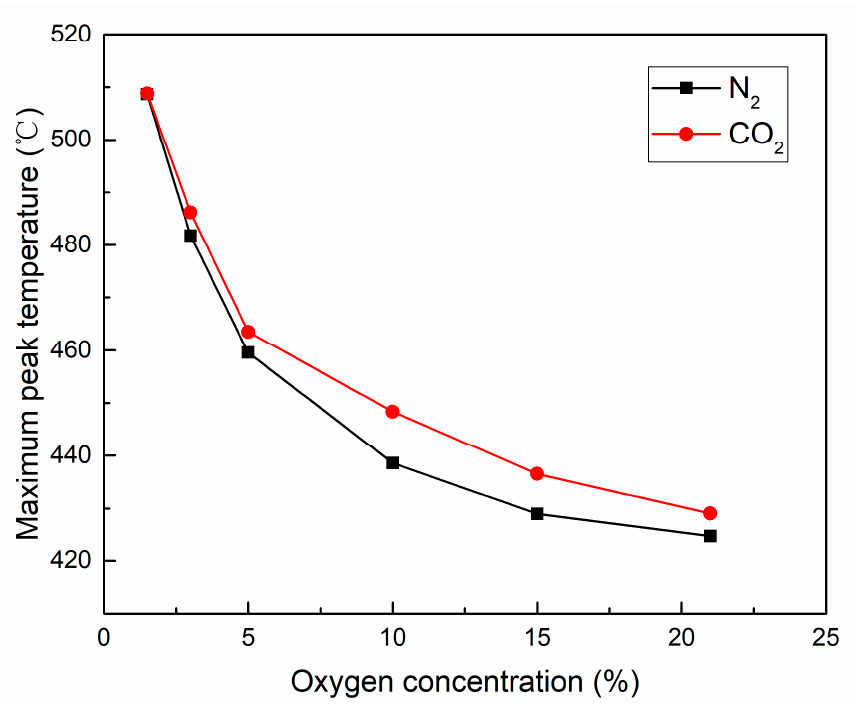
Figure 7. Maximum peak temperature of coal sample in the N 2 and CO 2 atmospheres.